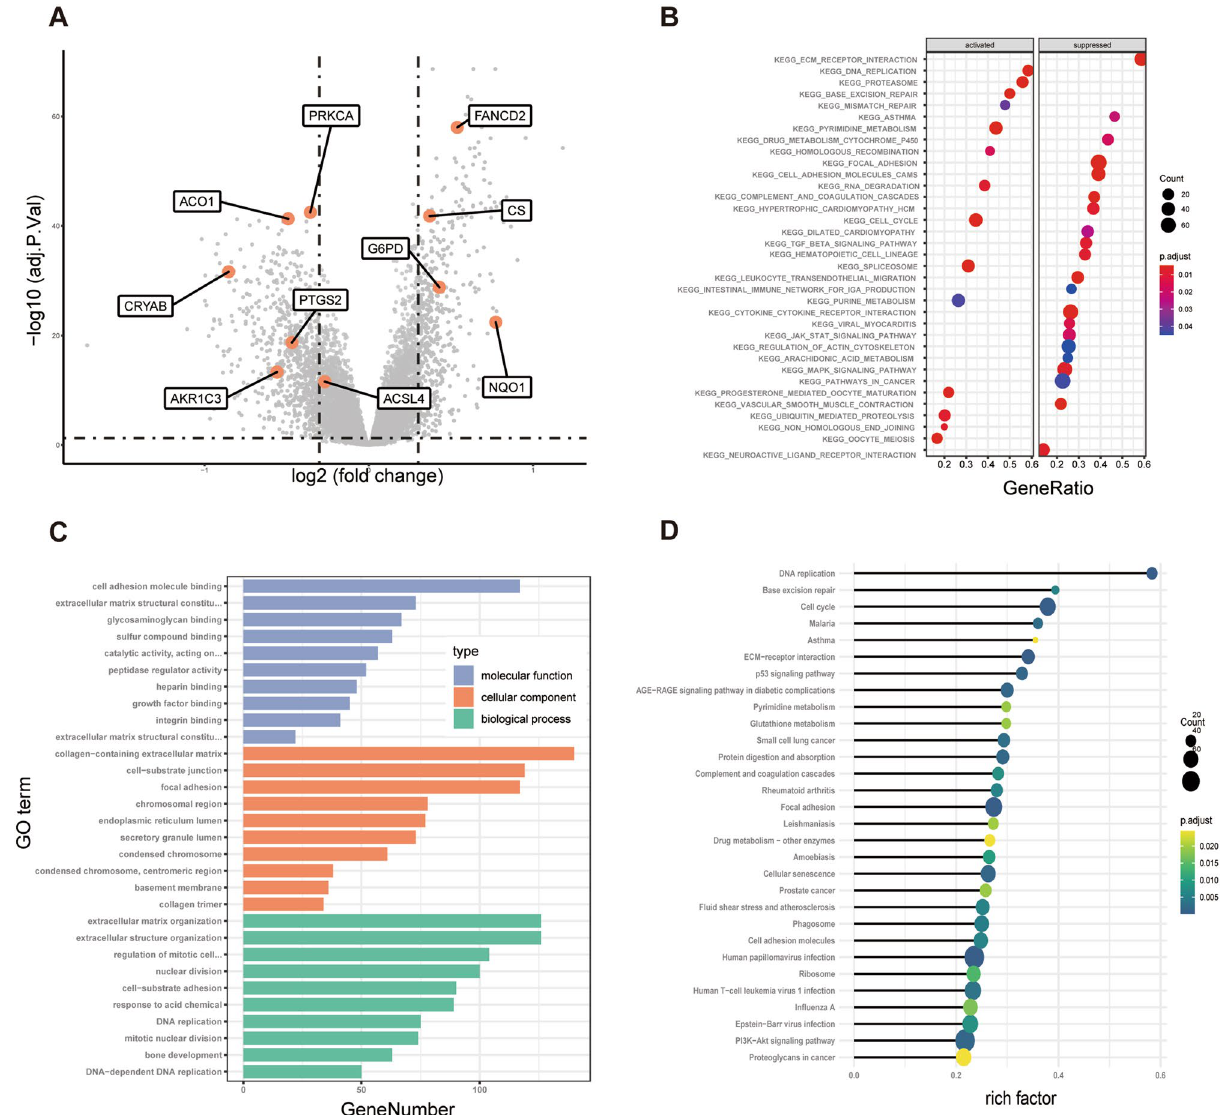
Figure 5. Functional annotation of genes differentially expressed between the low- and high-risk groups in the METABRIC derivation cohort. ( A ) Volcano plot of differentially expressed genes between the low- and high-risk groups. Orange indicates the 10 ferroptosis-related gene signature. ( B ) Enrichment plots from gene set enrichment analysis (GSEA) in the METABRIC cohort. ( C ) The most significant or shared GO enrichment terms in the METABRIC cohort. ( D ) The most significant or shared KEGG pathways in the METABRIC Moreover, energy metabolism has crosstalk with ferroptosis 39 . To our surprise, of the genes in the 10-gene prog- nostic model, only ACO1 was reported to be related to iron metabolism. The remaining genes could be roughly classified into other categories. CRYAB, FANCD2 and G6PD are related to energy metabolism. PRKCA, CS, and ACSL4 are included in the lipid metabolism category. The (anti)oxidant metabolism category includes NQO1, AKR1C3 and PTGS2. The analysis of these ferroptosis-related genes led to an interesting finding that most of the genes significantly related to prognosis in luminal-type BRCA are associated with the metabolism of the three major nutrients (glucose, lipids and amino acids). They are closely related to the tricarboxylic acid cycle (TAC). In contrast, there is less regulation of iron metabolism. ACO1, as an iron homeostasis-regulating gene, has been reported to regulate ferroptosis 5 . Genetic knockdown of PRKCA significantly protected rhabdomyosar- coma (RMS) cells from erastin-induced cell death 40 . CRYAB, a member of the small heat shock protein (sHSP) family, has been shown to be significantly differentially expressed in BRCA 41 . sHSP has an inhibitory effect on erastin-induced ferroptosis 42 . AKR1C3 has been proven to inhibit lipid peroxidation to promote ferroptosis confirmed by many studies as one of the hallmarks of the occurrence of ferroptosis 44,45 . G6PD is involved in the pentose phosphate pathway 46 . Dixon SJ et al. reported that G6PD, when knocked down in non-small cell lung cancer cells, prevents erastin-induced ferroptosis 5 . Ferroptosis caused by lipid peroxidation is controlled by